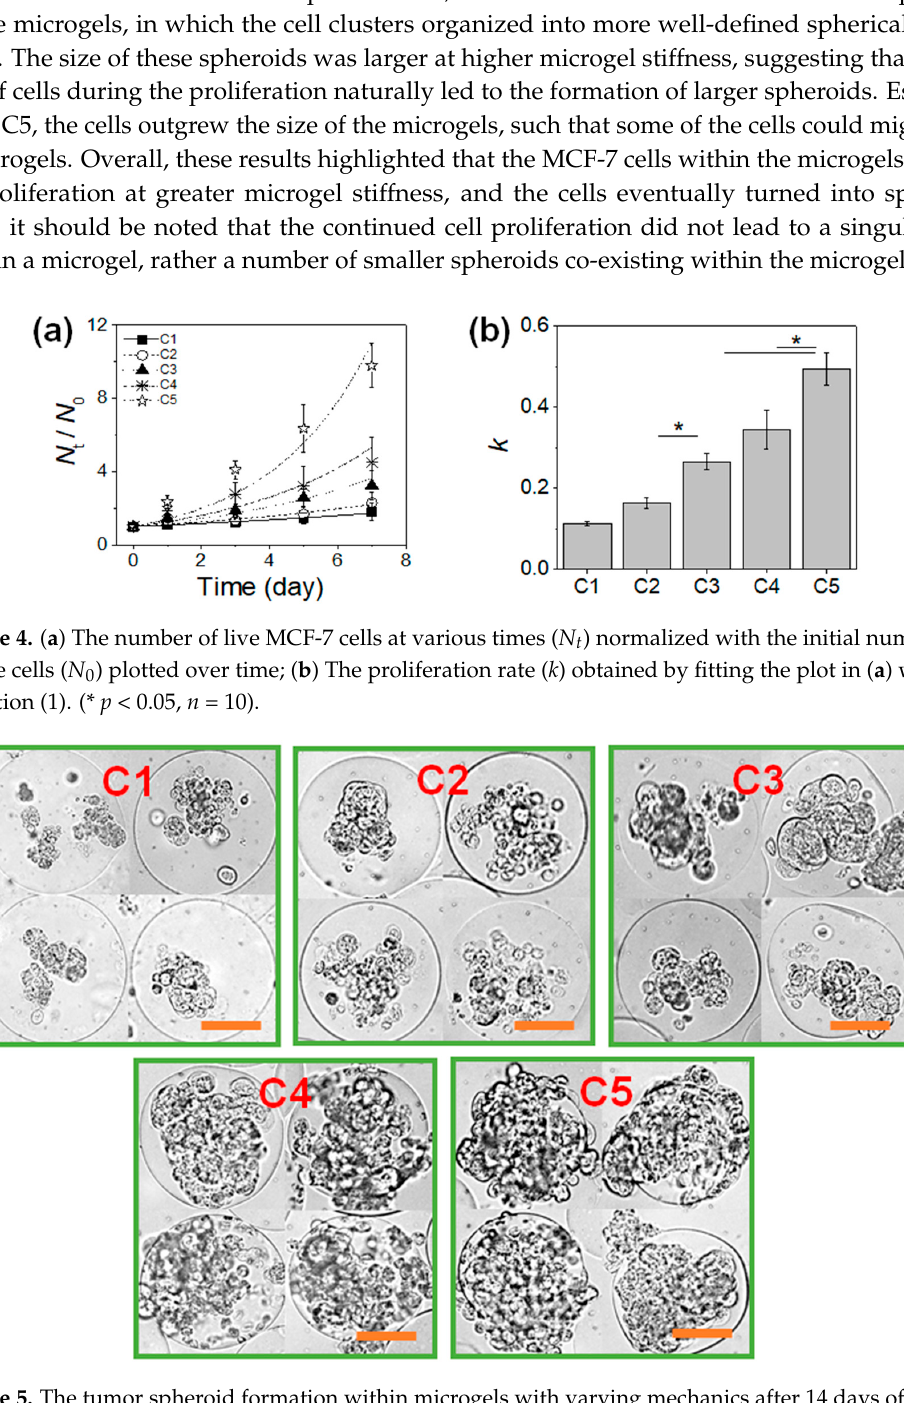
Figure 5. The tumor spheroid formation within microgels with varying mechanics after 14 days of cell culture (scale: 50 μ m). A collection of smaller spheroids was developed within the microgel.